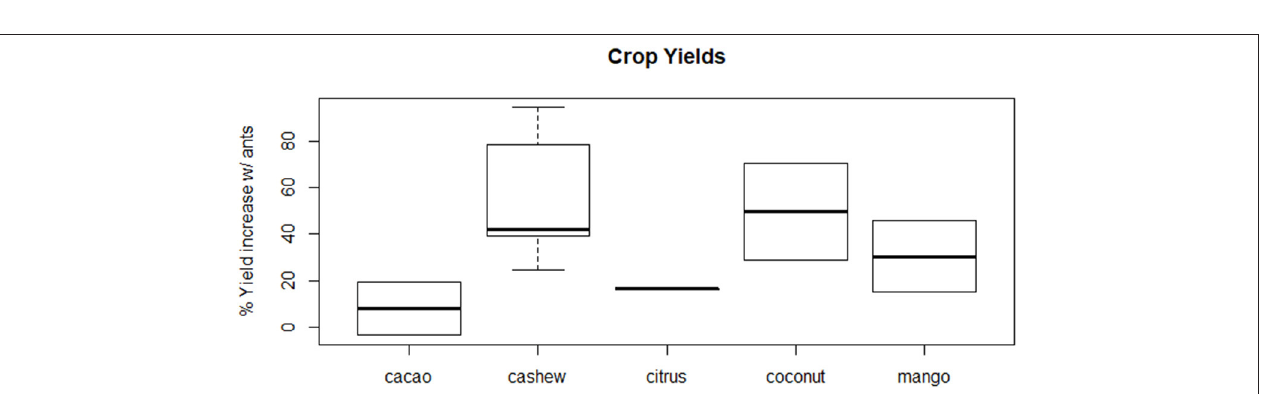
FIGURE 2 | Percentage of pest density (A) and pest damage (B) per tree for several tropical crops for trees with and without Oecophylla spp. ants. Ant treatments had significantly fewer pests and less pest damage than treatments without ants. Outliers are shown as white dots, while the solid black line indicates the median and the box shows the distribution of the dataset compiled from 25 studies (Peng et al., 1995, 1999, 2011, 2012, 2013, 2014; Sporleder and Rapp, 1998; Peng and Christian, 2004, 2005b, 2006, 2007, 2008; Ayenor et al., 2007; Van Mele et al., 2007; Adandonon et al., 2009; Dwomoh et al., 2009; Hosetti and Rudresh, 2012; Olotu et al., 2013; Pierre and Idris, 2013; Abdulla et al., 2015, 2016, 2017; Anato et al., 2015; Diame et al., 2015; Forbes and Northfield,